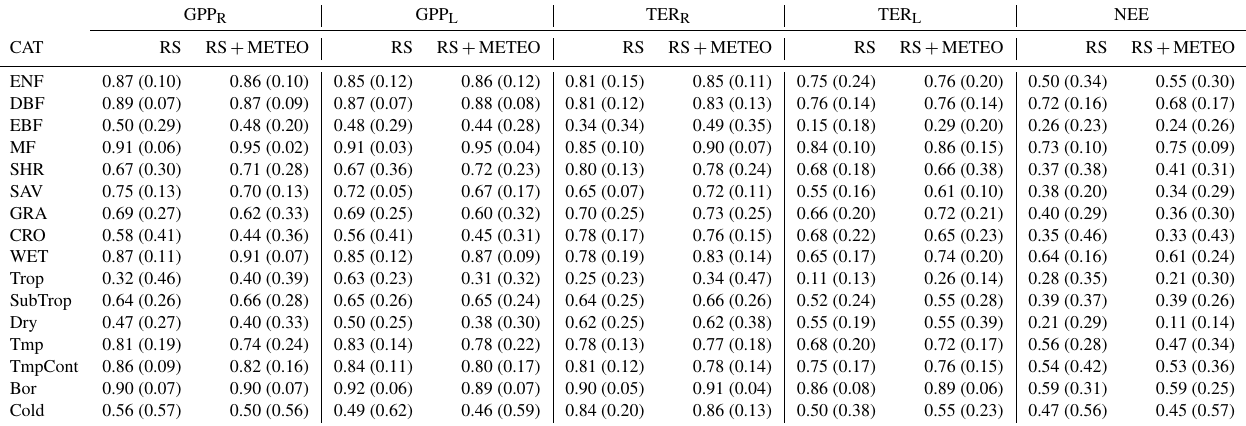
Table C1. Median site-by-site R 2 and its standard deviation (in parentheses and estimated as reported in Jung et al., 2009) for the CO 2 fluxes, per PFT and climate zones. List of acronyms: ENF, was evergreen needleleaf forest; DBF, deciduous broadleaf forest; EBF, evergreen broadleaf forest; MF, mixed forest; SHR, shrubland; SAV, savannah; GRA, grassland; CRO, cropland; WET, wetland; Trop, tropical; Sub- Trop, subtropical; Dry, dry and arid land; Tmp, temperate; TmpCont, temperate–continental; Bor, boreal; Cold, cold and polar environment or covered by ice.